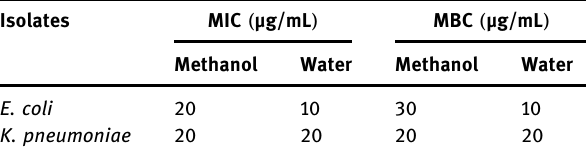
Table 2: Minimum inhibitory concentration and minimum bacteri - cidal concentration of methanolic and aqueous root extracts of P. indica against drug - resistant E. coli and K. pneumoniae